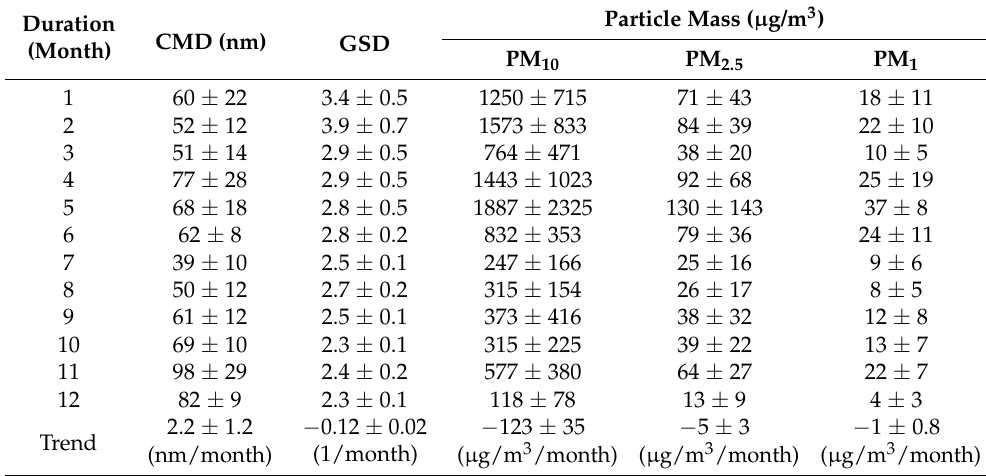
Table 1. Monthly paint dust CMD, GSD, and mass concentrations and trend (mean ± 3 × standard error).